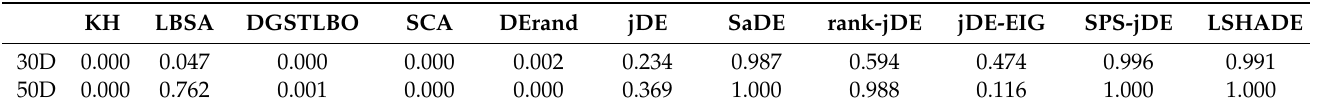
Table 6. The post hoc Duncan’s test results for CEC 2014.